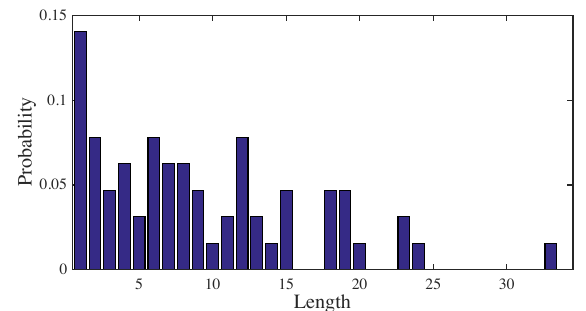
Figure 6 . The output probabilities of the start state, S st , esti- mated using eye tracking data of all participants.